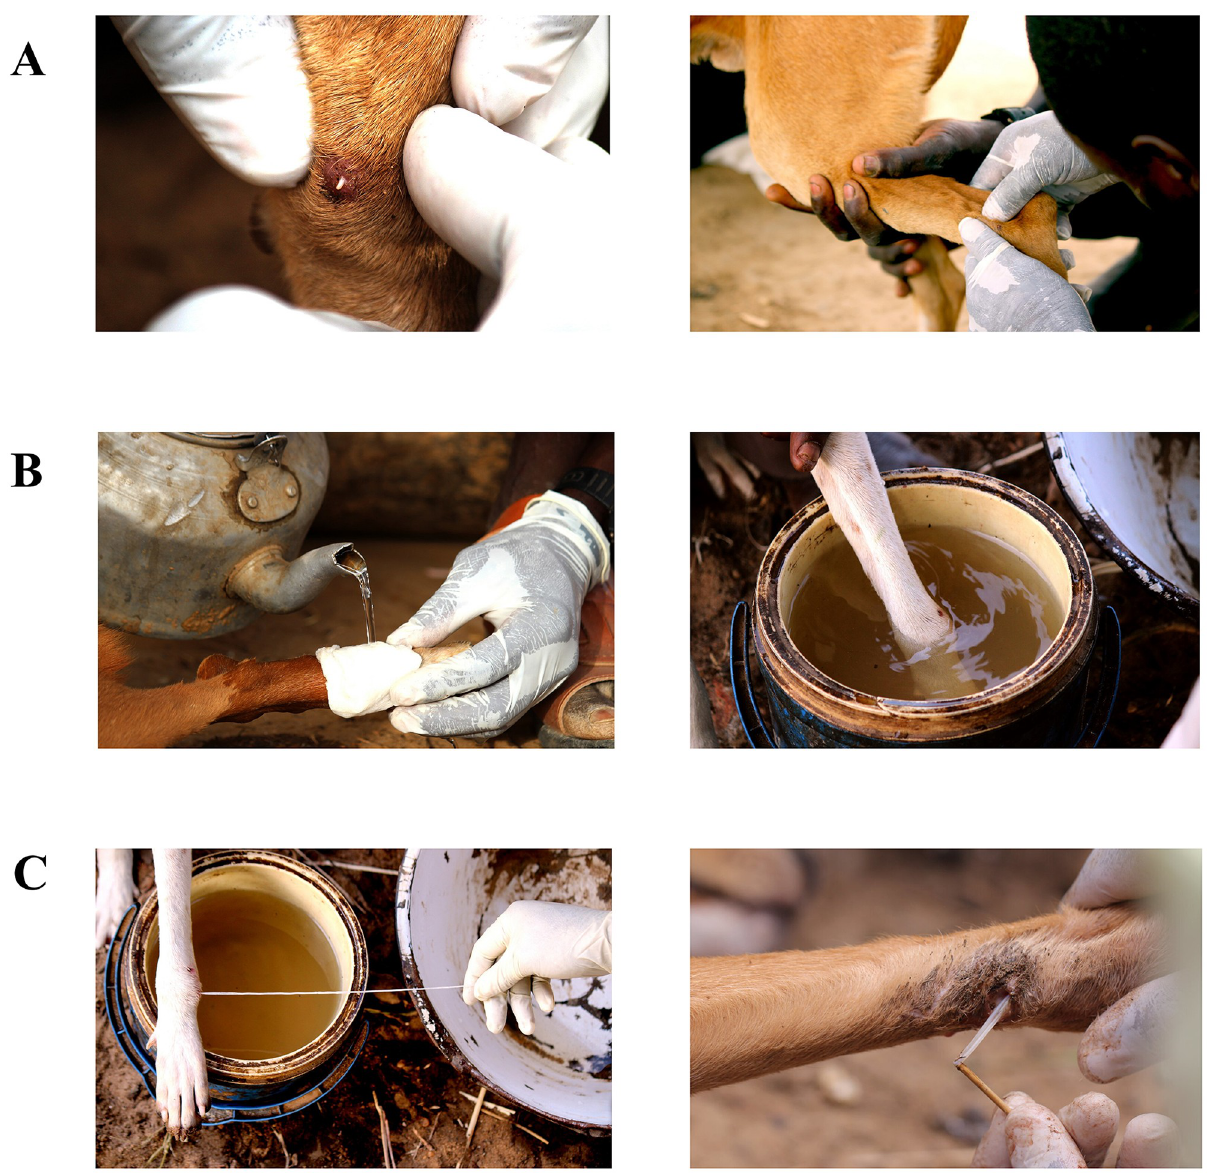
Fig 3. Worm extraction in dogs. The identification of pre-emergent worms (A) is challenging because blisters and worms are often obfuscated by dog fur. The “controlled immersion” technique (B) is performed by pouring water over the lesion (left) or submerging the lesion in a bucket of water (right) to allow female adult worms to release larvae within a contained environment. This water is then safely disposed of (e.g., poured on the ground away from any water sources). The worm is finally extracted (C) by gently pulling on the worm (left) or by wrapping it around a wetted gauze. A small stick is also sometimes used to initiate the process (right). Worm extraction in people can range from one day to 2–3 weeks [7, 22], but CGWEP field staff have reported that worm extraction in dogs is typically quicker than in humans. (Photo credits: Robert Hartwig, The Carter